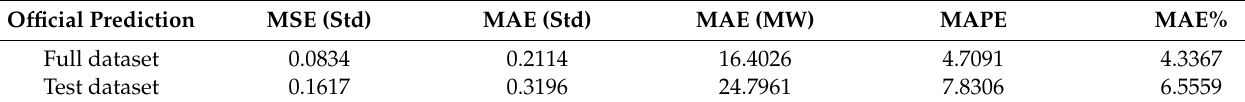
Table 5. Official load prediction on full and test dataset.